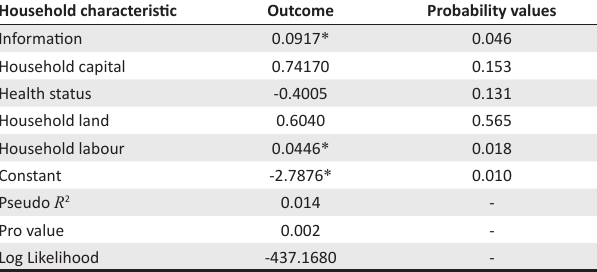
TABLE 3: Probit model for computing the propensity score. Household